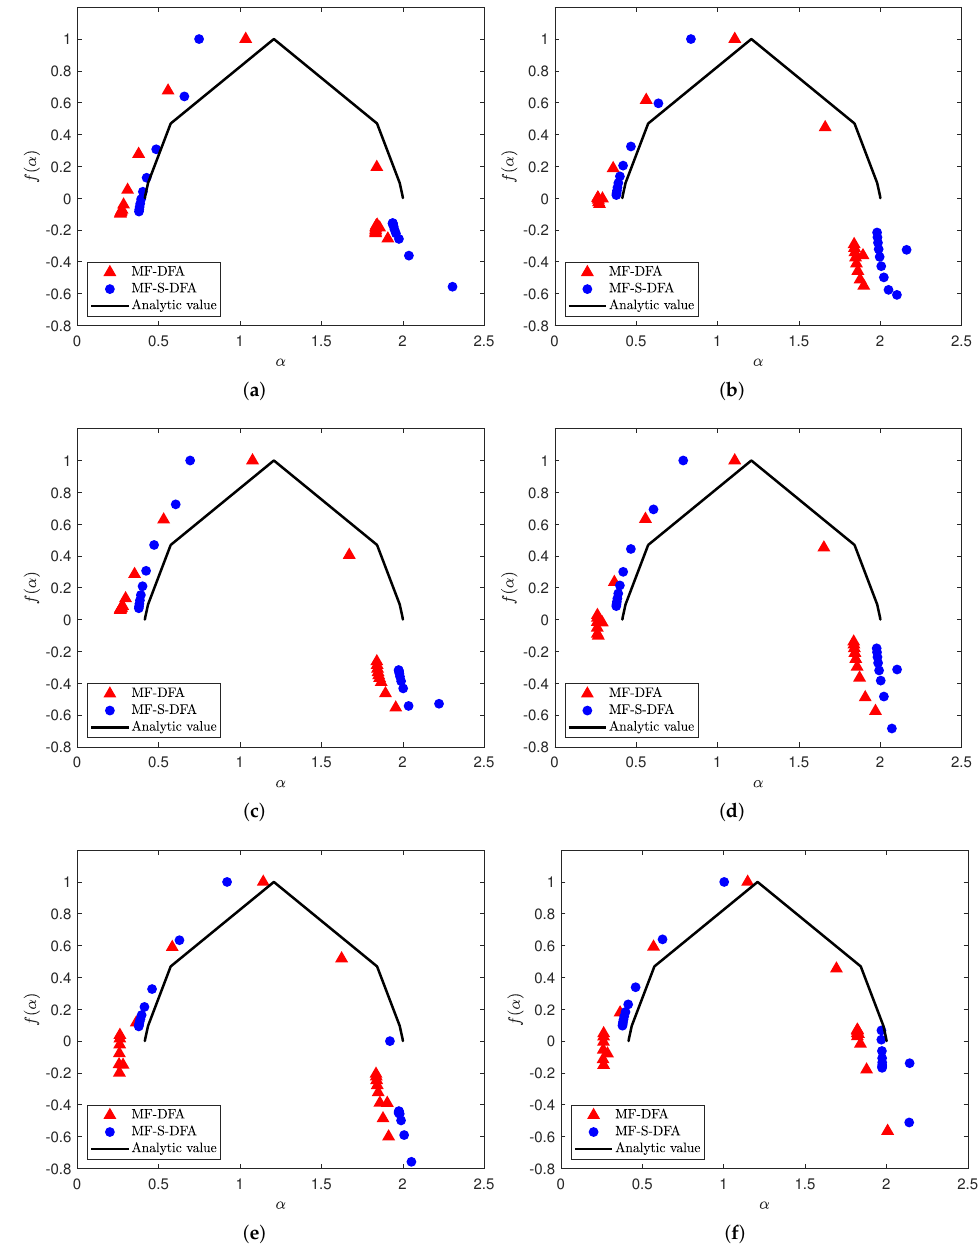
Figure 4. Multifractal analysis of the constructed multiplicative cascades time series comparison of the singular spectrum f ( α ) under different parameters n max . ( a – f ) represent n max = 8, 9, 10, 11, 12 and 13, respectively. A color version of the figure is available in the web version of the article. (cid:113) ∑ ( H err ( q )) 2 Furthermore, we develop the distance function D H = to calculate the n overall distance between the generalized Hurst exponent numerical solutions and the (cid:113) ∑ ( τ err ( q )) 2 theoretical solutions. Similarly, D τ = is adopted for measuring the numer- n ical solution of the scale exponents and the corresponding theoretical values. That is, the smaller the distance between D H and D τ , the higher the effectiveness and accuracy of the corresponding method. From Table 1, we note that for both D H and D τ , the values of MF-S-DFA are less than those of MF-DFA, implying the MF-DFA model with sign retention is more suitable for the real multifractal characteristics of time